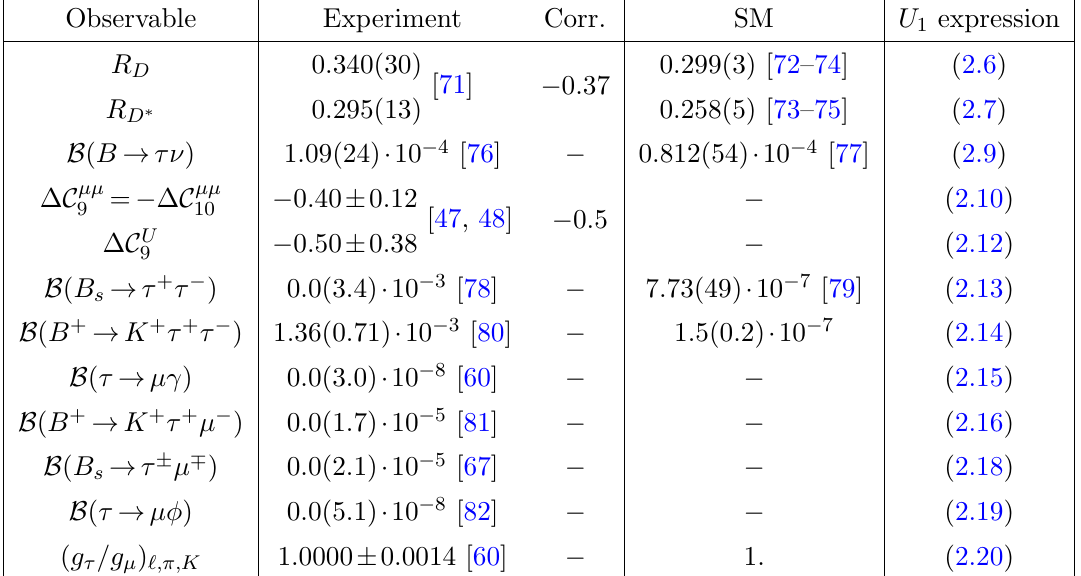
Table 1 . List of observables included in the (cid:12)t. The experimental values and SM predictions are also shown. The expressions of the observables in terms of the U 1 parameters are reported in section